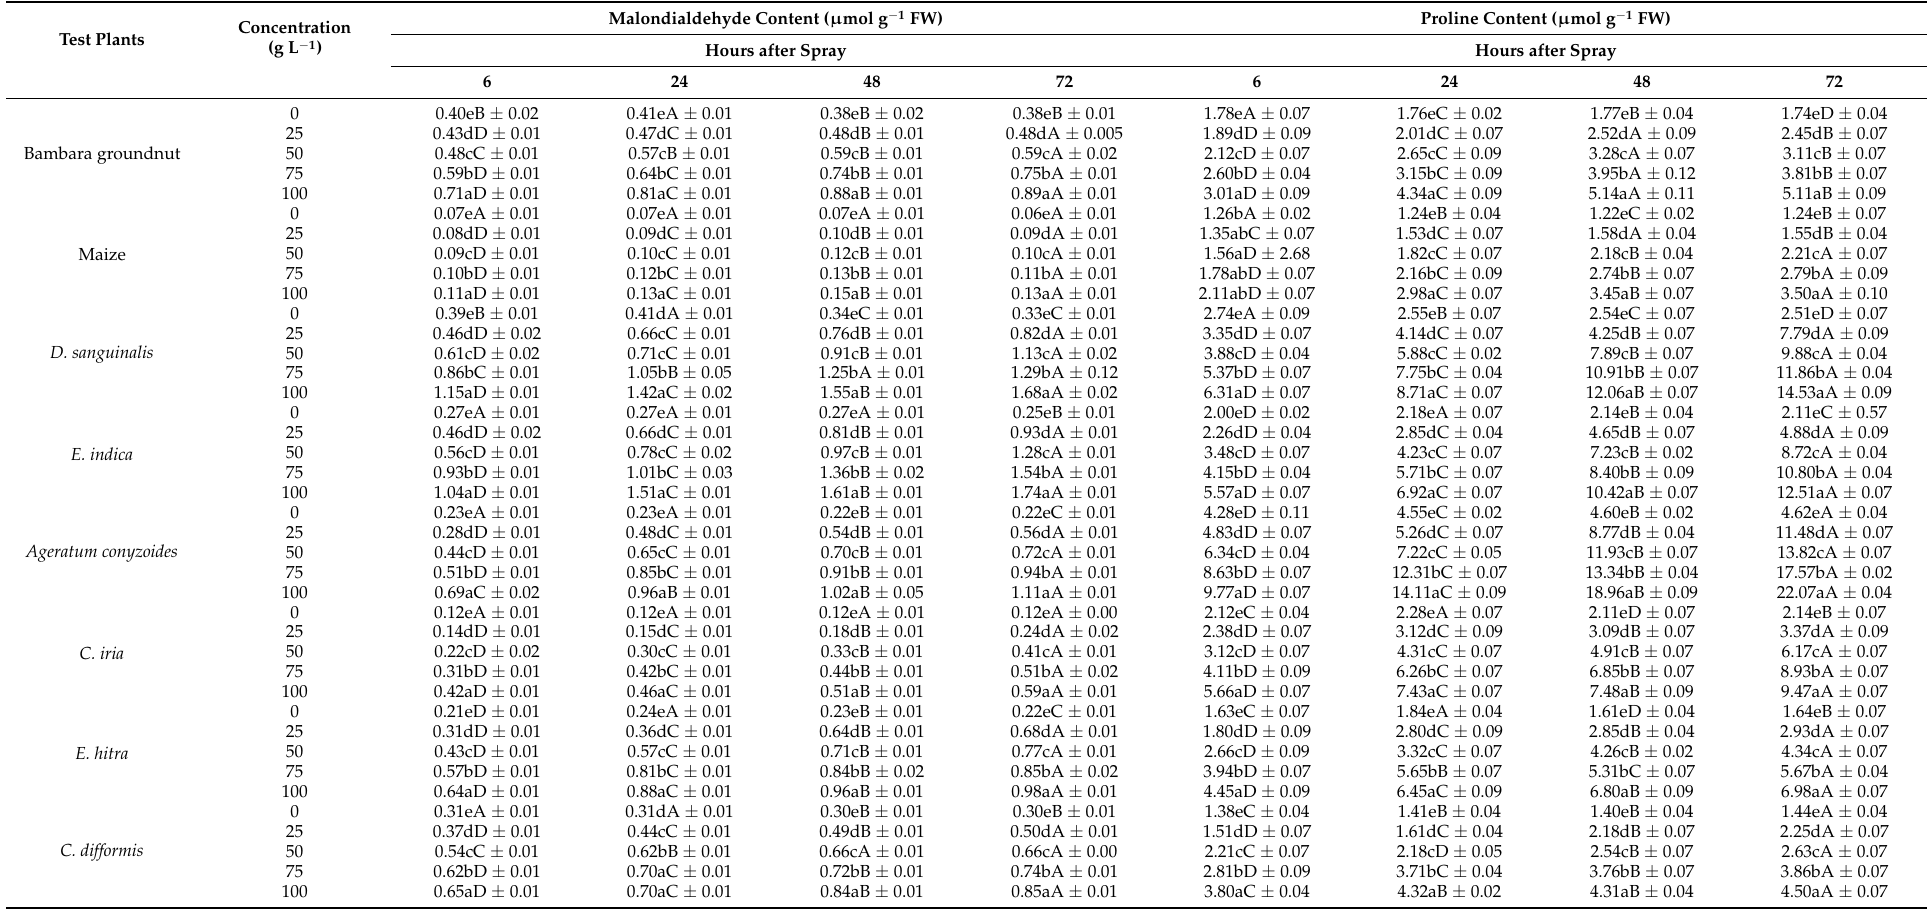
Table 6. Response of malondialdehyde and proline content of some crops and weeds due to the foliar spray of P. hysterophorus leaf